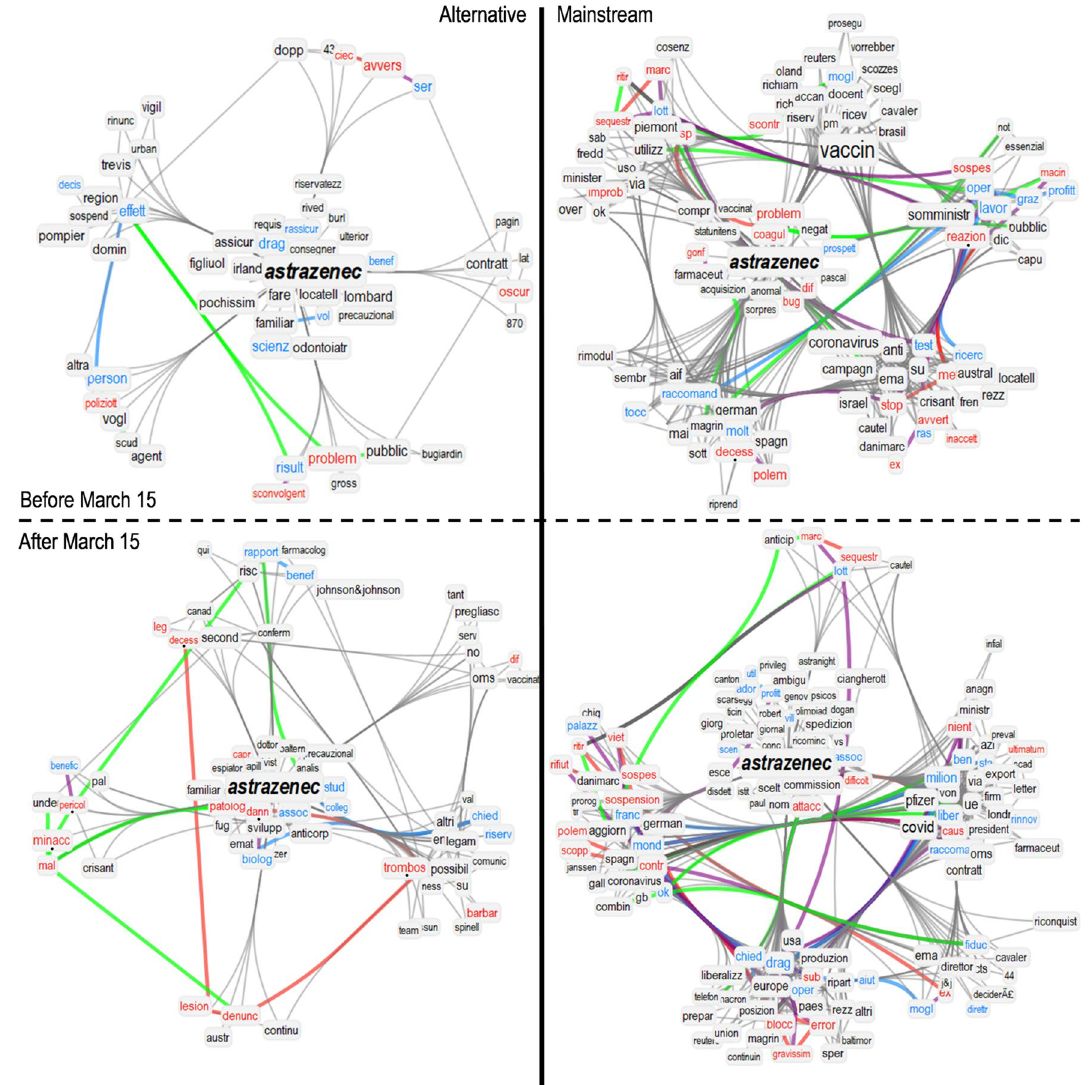
Figure 2. Semantic frames of tightly linked concepts around “astrazenec” in journal news titles from mainstream sources (right) and alternative sources (left), before (top) and after (bottom) the temporary suspension of 15 March 2021. We highlighted with a dot those words discussed in detail in the main text, i.e. thrombosis, reactions, death and allergies. Syntactic links between positive (negative, neutral) words are in cyan (red, grey). Syntactic links between positive and negative words are in purple. Green links indicate